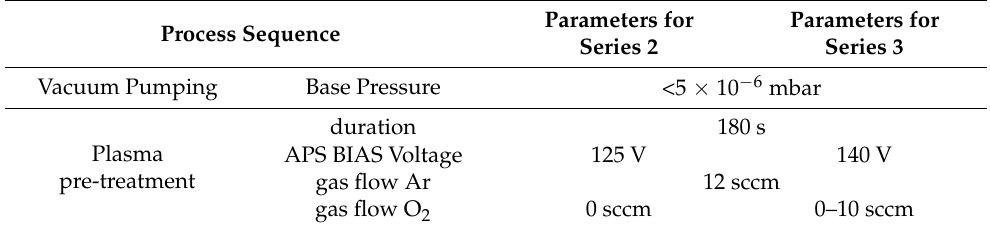
Table 3. Process sequence and parameters for aluminum deposition series 2 and